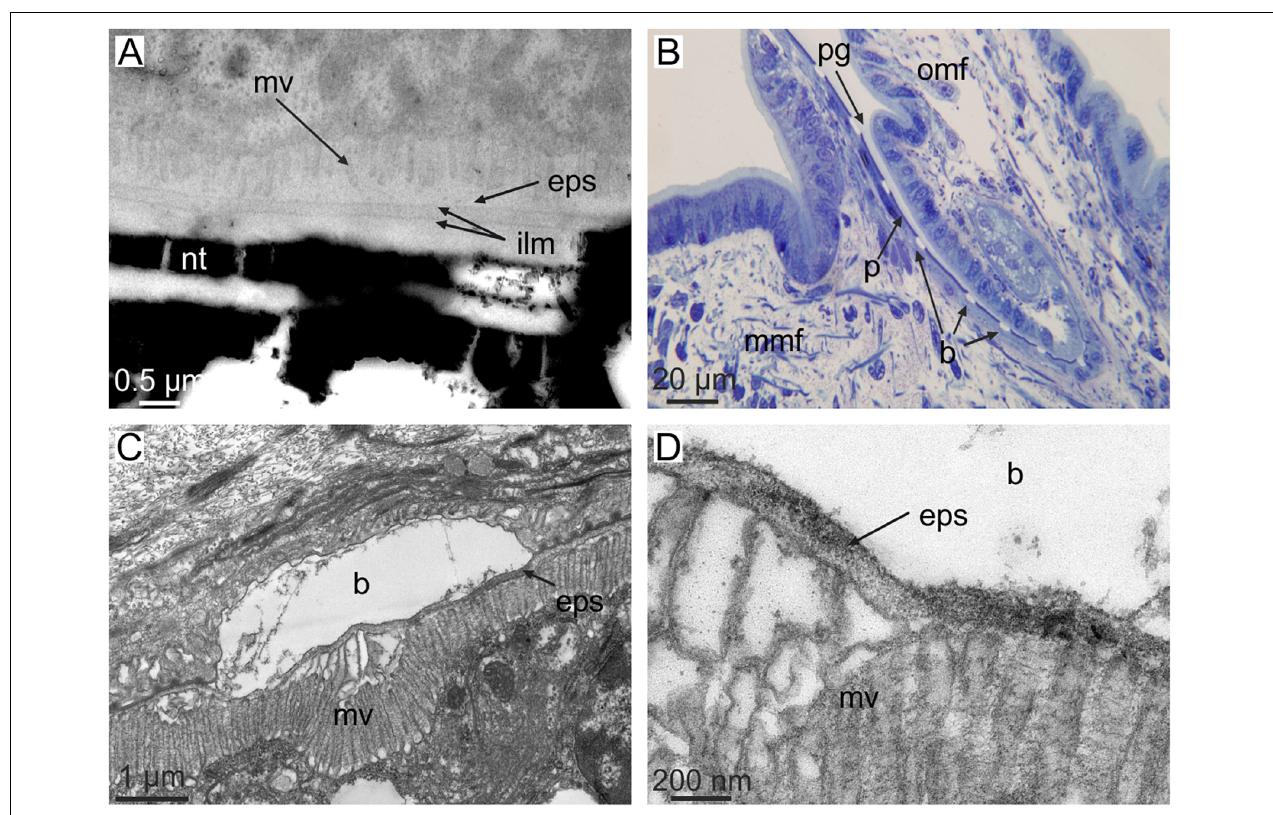
FIGURE 3 | The dimensions of the extrapallial space in bivalves. (A) Section through the shell and mantle of Pinctada fucata . Note the short distance between microvilli and the forming interlamellar membranes (i.e., the extrapallial space). Original material from H. Nakahara. (B–D) Sections through the mantle edge (B) and periostracal groove (C,D) of Neotrigonia margaritacea (decalcified sample). The view in (B) shows the periostracum, together with mineral bosses of the prisms being formed within the periostracal groove. (C,D) Show the relative positions of the crystalline bosses and the cell microvilli. The close-up view in (D) permits estimating an approximate thickness of the extrapallial space of ca . 100 nm. b, boss; mv, cell microvilli; eps, extrapallial space; ilm, interlamellar membrane; mmf, middle mantle fold; nt, nacre tablet; omf, outer mantle fold; p, periostracum; pg, periostracal groove. (C,D) Modified from Checa et al.